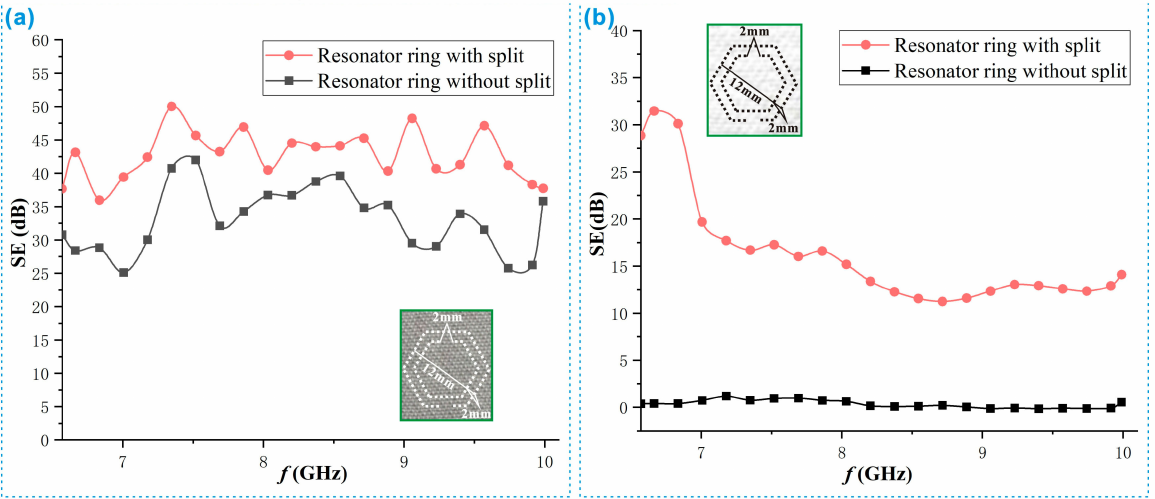
Figure 4. Comparison of the SE of the fabric before and after the SRR implantation. ( a ) Stainless steel EMS fabric and ( b ) Ordinary cotton